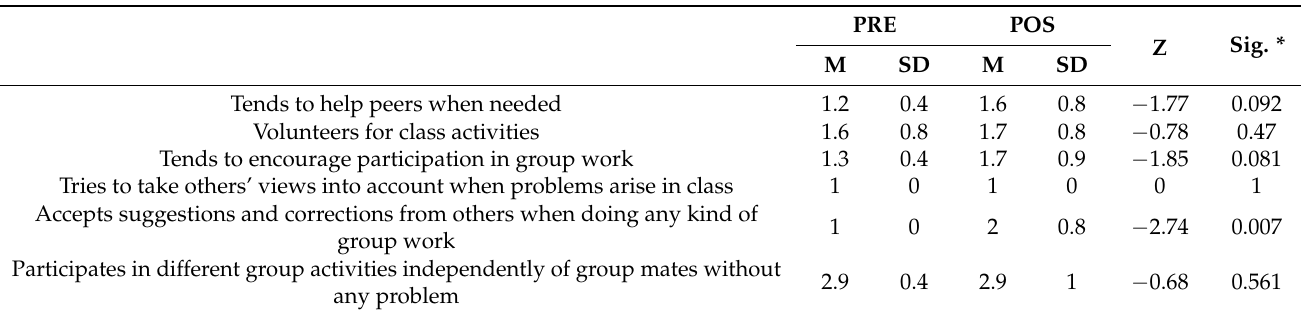
Table 10. Assistance/cooperation.